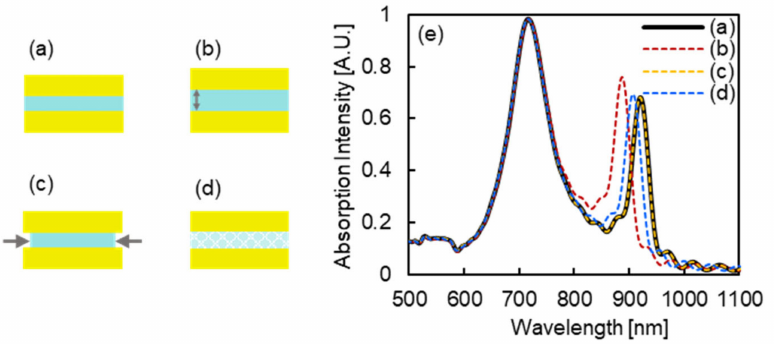
Figure 9. ( a – d ) The base MIM nanostructure and the possible structural changes compared to the base structure adopted to investigate the reason for the 20 nm shorter wavelength shift in Figure 8b. ( a ) The base MIM nanostructure with its structural parameters: 30 nm of Au layer thickness; 20 nm of MgF 2 layer thickness; and 140 nm of diameter. ( b ) An MIM nanostructure in which MgF 2 layer thickness was increased by 5 nm, ( c ) an MIM nanostructure in which the MgF 2 layer radius was decreased by 5 nm, and ( d ) an MIM nanostructure in which the RI value of the MgF 2 layer was decreased by 0.05. ( e ) Absorption spectra of MIM nanostructures in ( a – d ). The black line indicates the absorption spectrum of the structure in ( a ), and the red, yellow, blue dashed lines indicate the absorption spectra of the structures in ( b – c ),